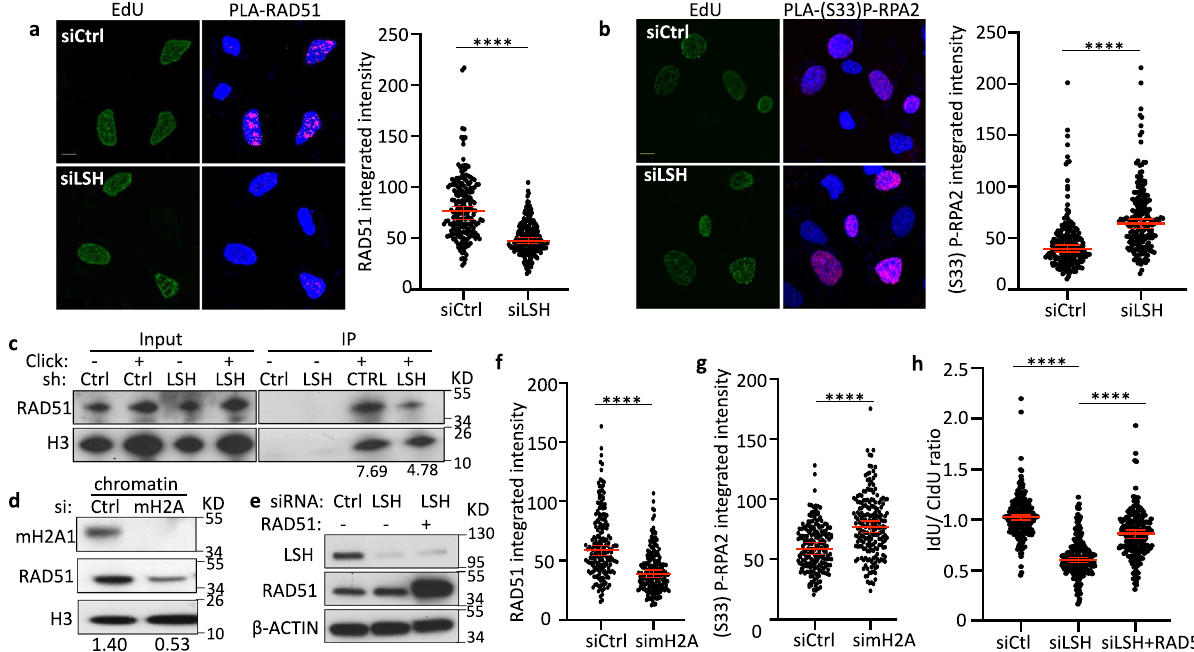
Fig. 4 Impaired RAD51 deposition at stalled replication forks. a PLA analysis for U2OS cells transfected with the indicated siRNA (siCtrl or siLSH) and pulsed with 10 µ M EdU for 20 min before exposure to 4 mM HU for 5 h. The scale bar represents 10 µ m in the representative image. Quanti fi cation of PLA signals (RAD51: EdU) is based on EdU-positive cells. Representative of n = 3 independent experiments. Data are represented as median ± 95% CI ( n = 200 cells). **** p < 0.0001 by two-tailed Mann – Whitney test. b Representative images and quanti fi cation of PLA signals (S33P-RPA2: EdU) from U2OS